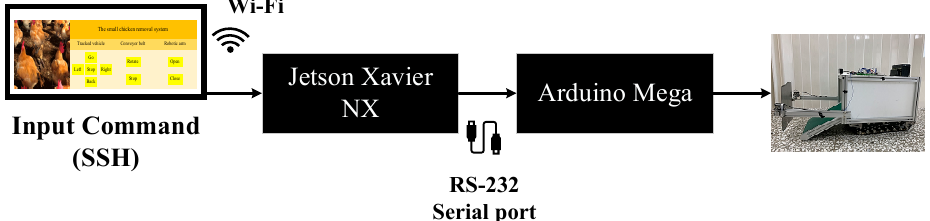
Figure 3. Signal transmission architecture.